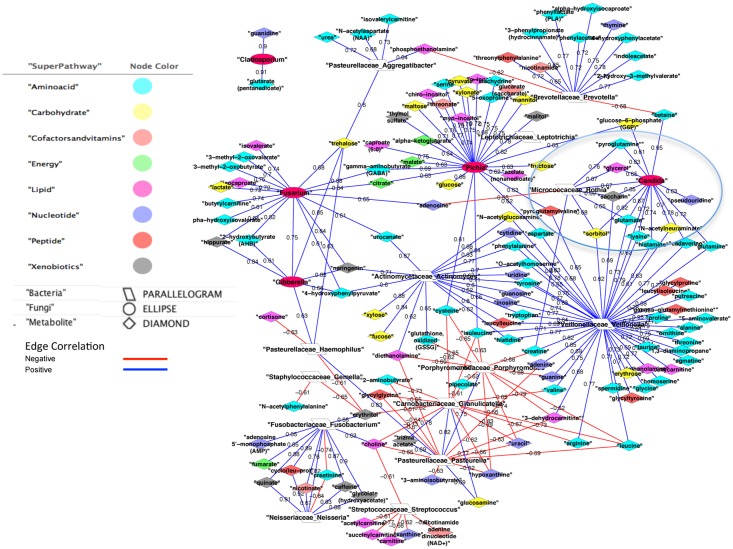
MBF Control cohort significant correlations (rho >0.6 or rho <-0.6).A blue edge connotes a positive correlation, red negative. The correlation value is listed on the edge. The node shape defines the type; diamond is metabolite, parallelogram is bacteria, and circle for fungi. The location of the node, and the link length, and orientation, are not important.